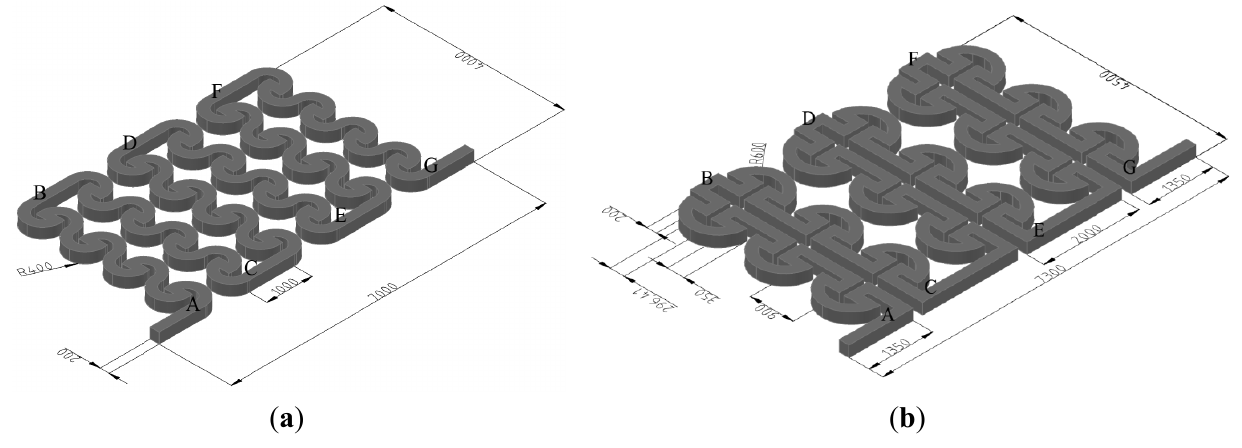
Figure 3. Dimensioned geometries of the ( a ) ILSC and ( b ) Ω